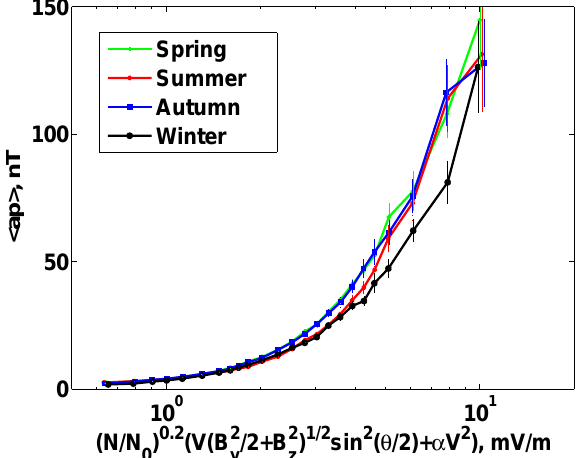
Fig. 3. a p seasonal variations in driving